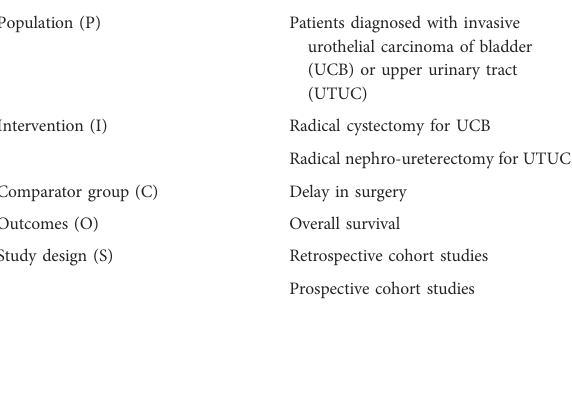
TABLE 1 Population, intervention group, comparator group, outcomes and study design (PICO) of studies included in this systematic review and